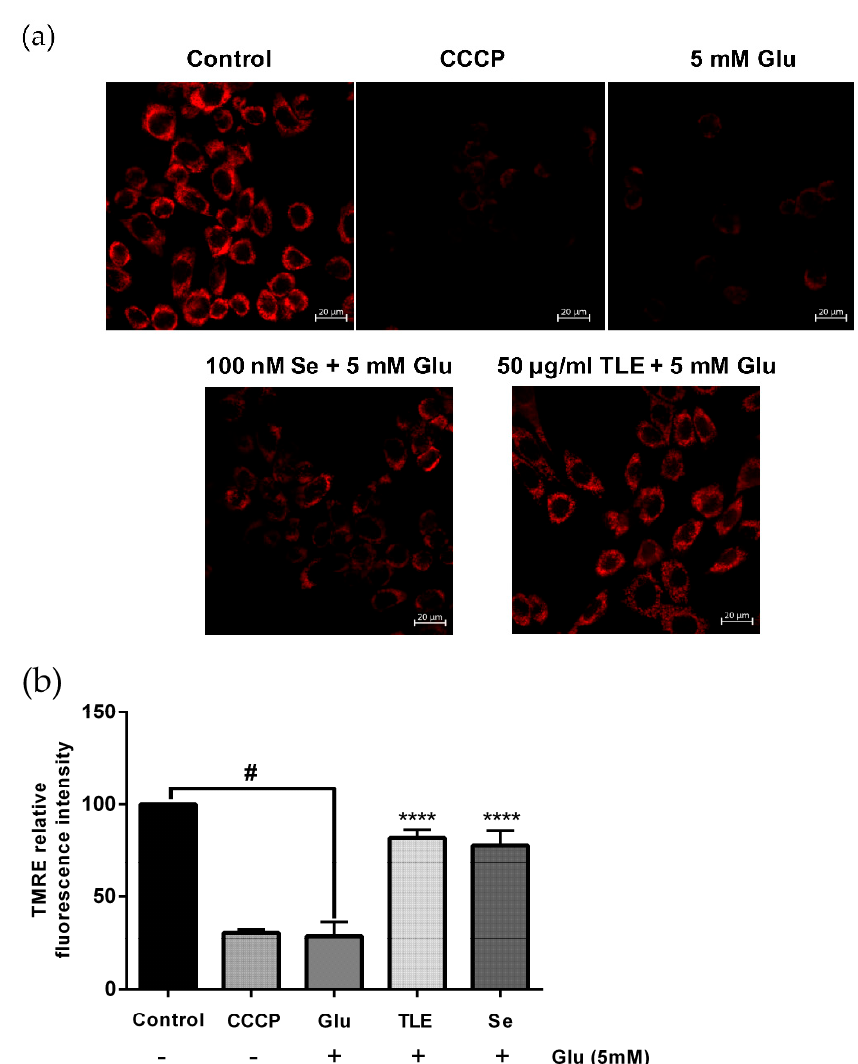
Figure 3. TLE restores mitochondrial membrane potential status. HT-22 cells (passage 911) were pre-treated with TLE at 50 µ g/mL or selenium for 24 h followed by 5 mM glutamate. ( a ) The status of the mitochondrial membrane potential of each treatment was stained using a TMRE probe. They were observed under the confocal laser scanning microscope; scale bar 20 µ m. ( b ) Data are expressed as the relative TMRE level of the non-treated control. CCCP, mitochondrial uncoupling agent. Values were collected from at least three independent experiments and the results are shown as mean ( n = 3). **** p value < 0.001 compared with glutamate treatment group, # p value < 0.001 compared with untreated